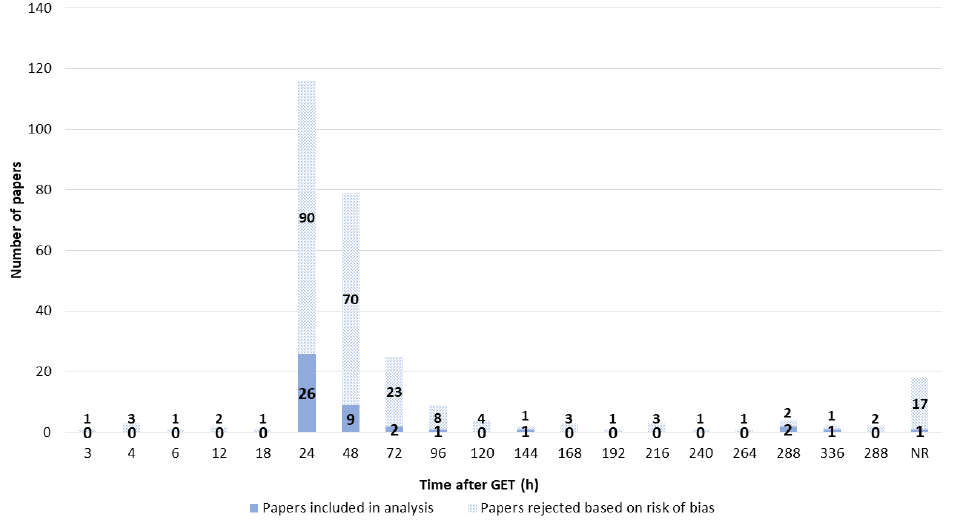
Figure 14. Time at which GET was